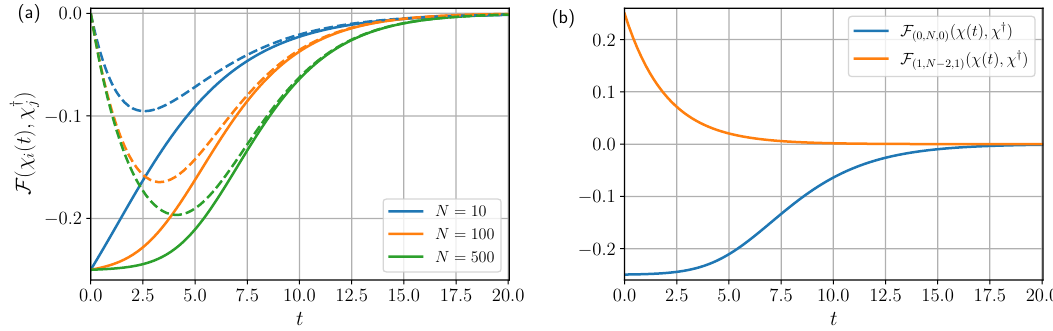
) vs time for i = j (dashed lines) and i 6 = j (solid lines) Figure 5 . (a) The overall OTOC F ( χ i ( t ) , χ † j for different values of N . The OTOC decays to zero at late times as expected from scrambling, which is in contrast with the non-interacting ( q = 2) case given in eq. (5.29). (b) The OTOC syk resolved into the contributing irreps, according to eq. (5.25), for N = 500 particles. The scrambling behavior is present in the (0 , N, 0) irrep while the (1 , N − 2 , 1) irrep displays an exponential decay at all